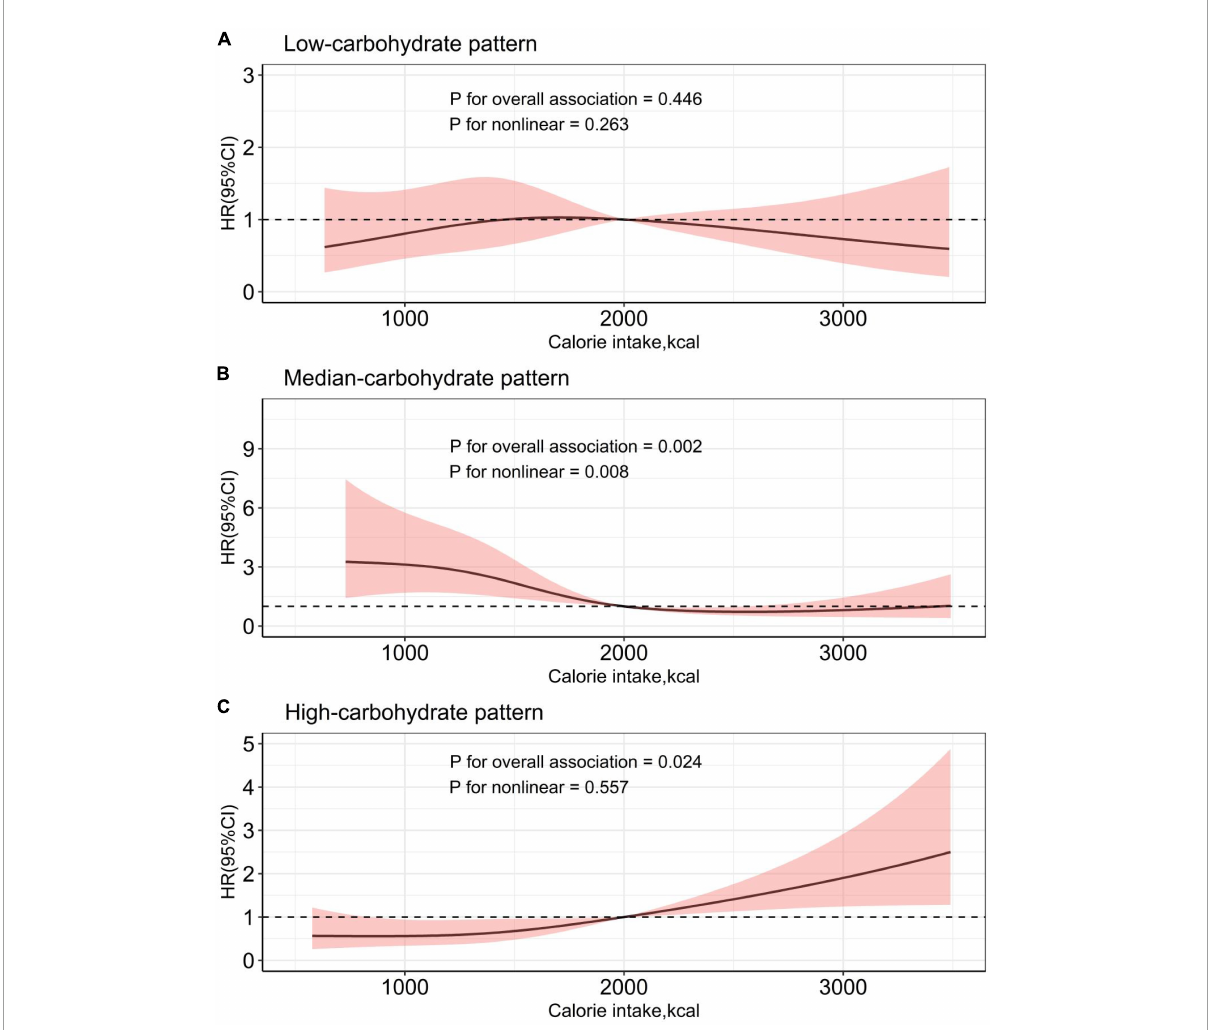
FIGURE4 Calorie intake and risk for all-cause mortality of heart failure in different dietary